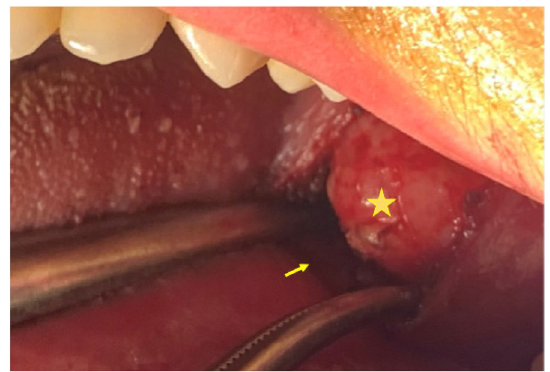
Fig. 4 Per-operative view of transoral resection of the tongue base submucosal mass (star) throw a lateral incision (arrow)